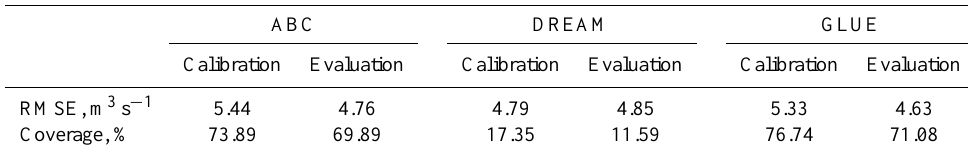
Table 4. Statistics of the GLUE, ABC and DREAM (formal likelihood function) derived posterior parameter distribution for the calibration and evaluation period of the French Broad river basin: root mean square error (RMSE) of the posterior mean SAC-SMA simulation and coverage of the associated 95% streamflow simulation uncertainty ranges.